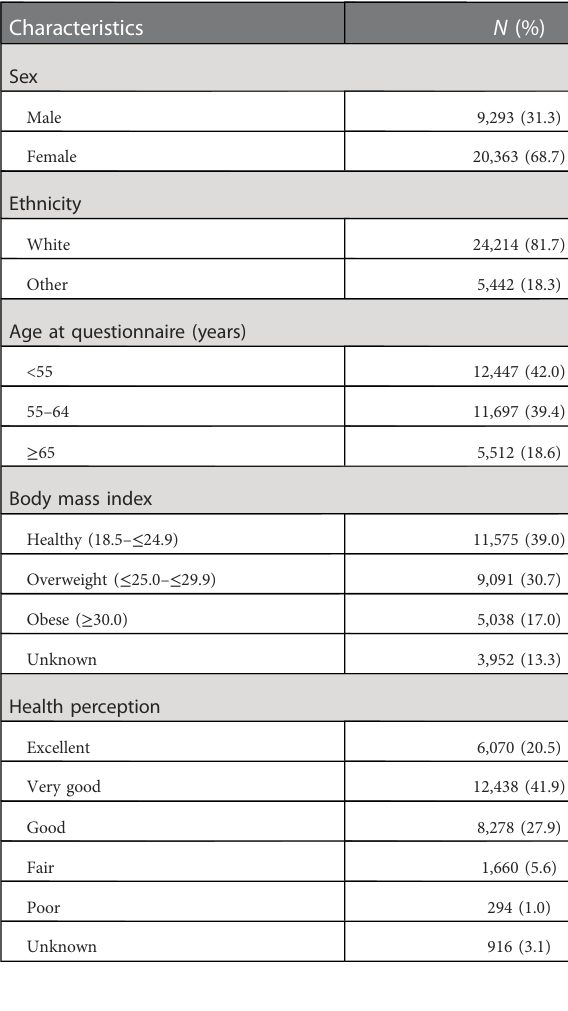
TABLE 1 Characteristics of participants ( N